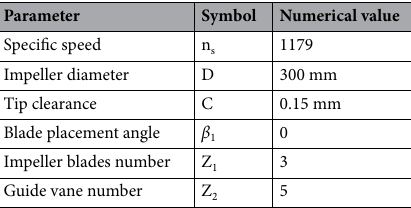
Table 1. Main geometric parameters of the axial flow pump hydraulic model.